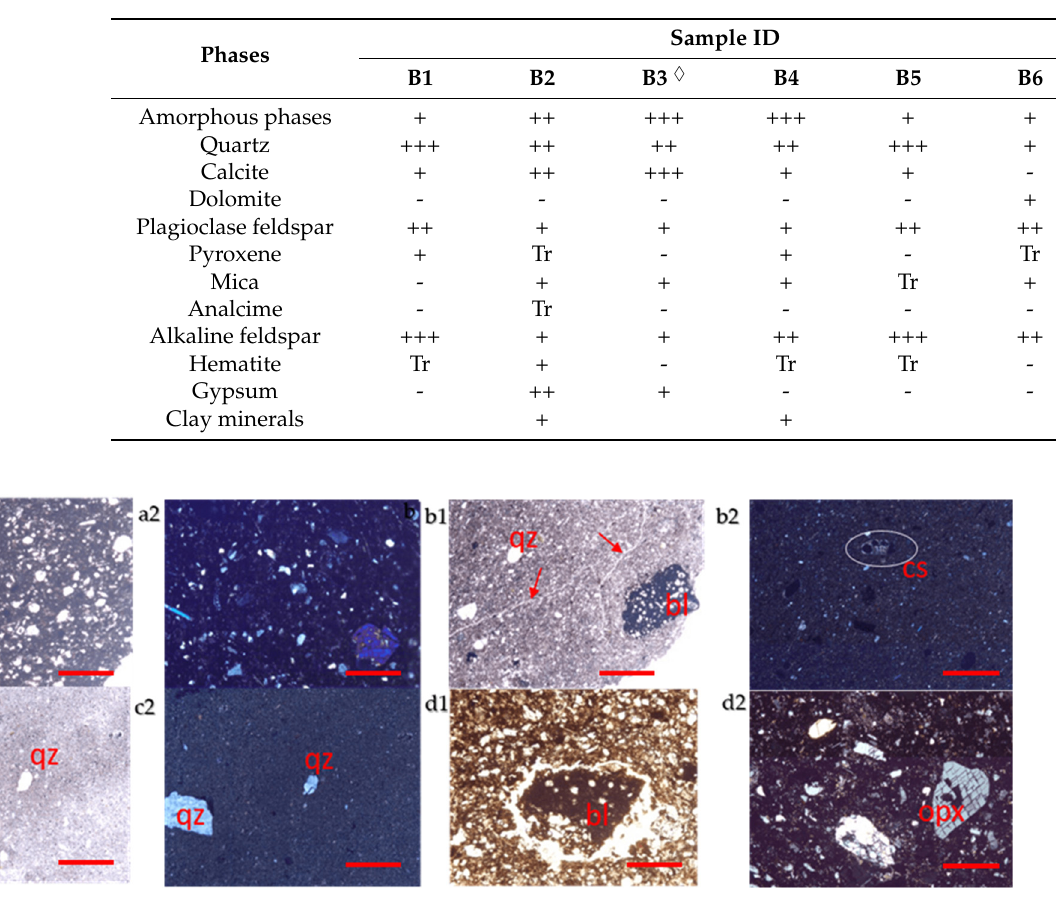
Figure 5. Microphotographs of brick samples. ( a ) sample B1; ( b ) sample B2; ( c ) sample B3 (yellow); ( d ) sample B4; a1, b1 c1 and d1 plane polarized light; a2, b2, d2, c2 crossed polarized light. All microphotographs are at 4× magnifications. bl = black lump; cs = carbonate shell; opx = orthopyroxene; qz = quartz; red arrows indicate firing stress lines. Line red bar = 1 mm.